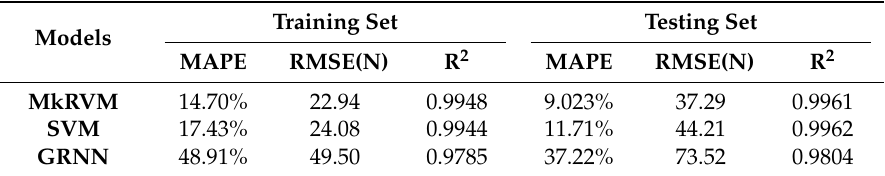
Figure 16. The comparison of correlation coefficient between measured Dp and predicted Dp from the MkRVM, SVM and GRNN. Table 3. Comparison of the prediction performance among the MkRVM, SVM and GRNN.